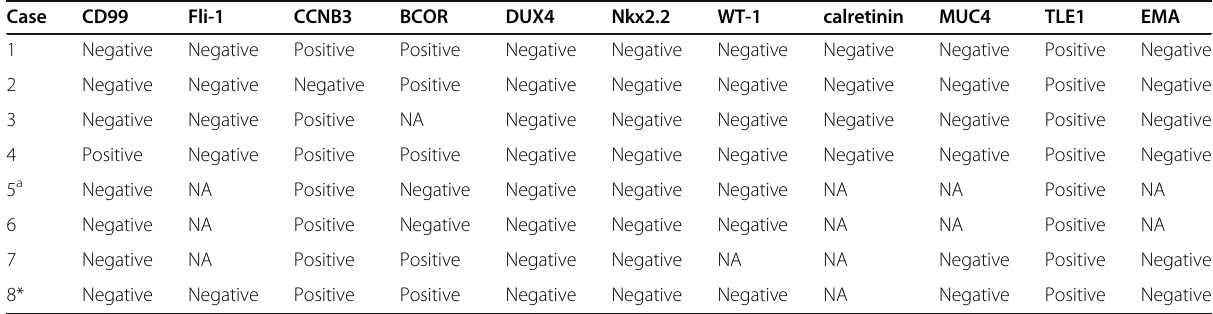
Table 2 IHC characterisations in BCS Patients